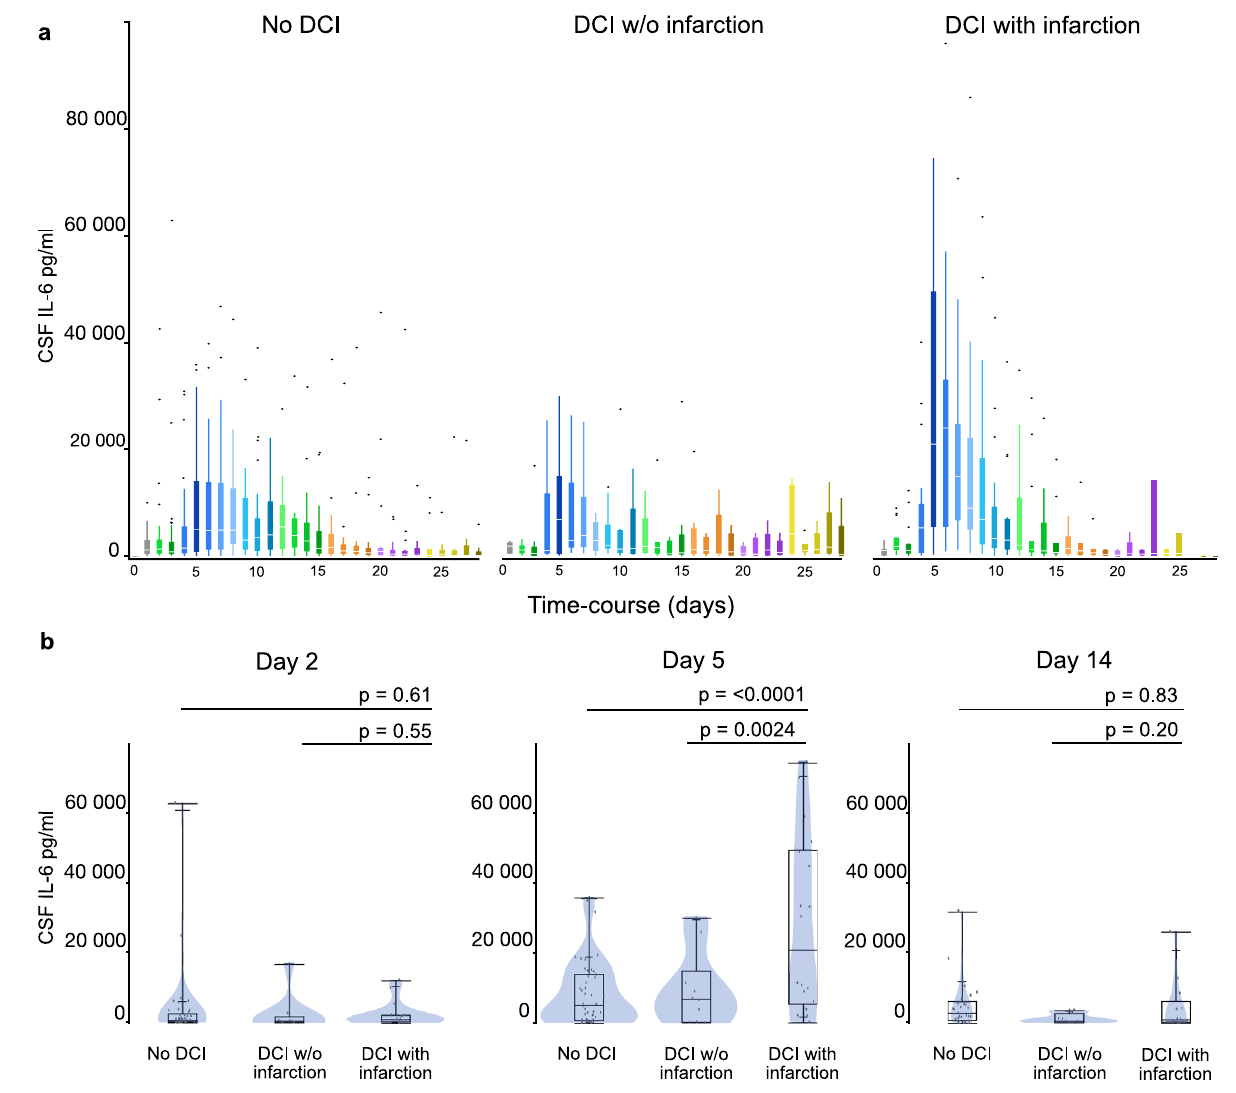
Figure 2. Interleukin 6 CSF levels in cases with no DCI, with DCI and no infarction, and in patients with DCI and infarction. ( a ) In all three patient groups a significant increase of CSF IL-6 levels was seen in the first week after SAH with a peak on day 5 (day 1 vs. day 5; no DCI P = 0.039, DCI w/o infarction P = 0.003, DCI with infarction P < 0.001). ( b ) Boxplots show the inter-group comparison for days 2, 5 and 14. While median CSF IL-6 levels did not differ significantly on day 2 (DCI with infarction vs. no DCI and ~ vs. DCI w/o infarction: P = 0.61 and P = 0.55), there were significant differences between median CSF IL-6 levels in the DCI with infarction group and both other groups (no DCI and DCI w/o infarction: P < 0.0001 and P = 0.0024) on day 5. This effect persists for several days (not shown) and is no longer seen on day 14 (DCI with infarction vs. no DCI and ~ vs. DCI w/o infarction: P = 0.83 and P = 0.20).